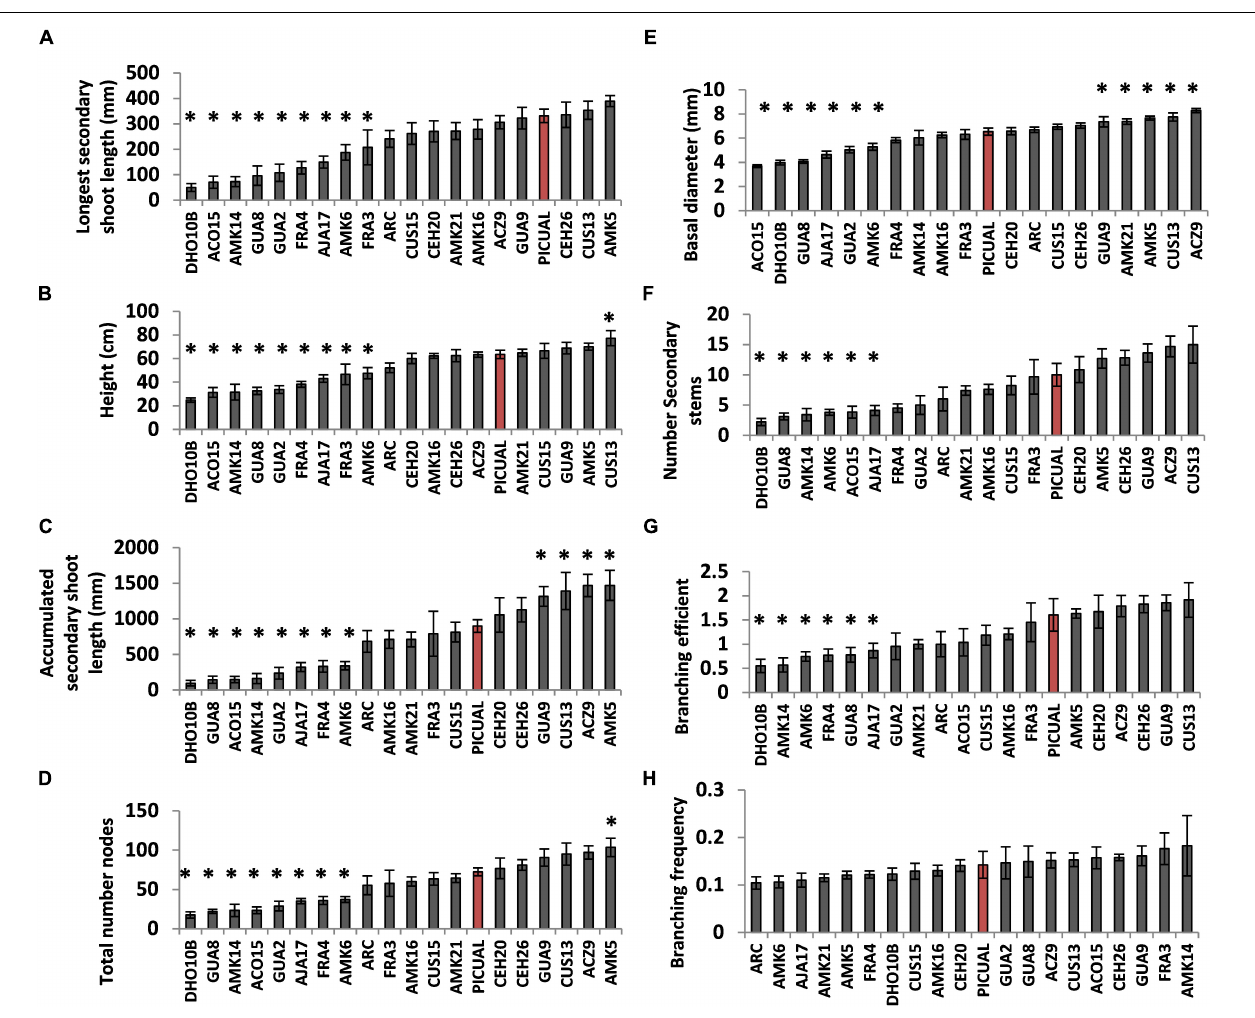
FIGURE 5 | Comparison of morphological parameters measured in the Picual scion grafted on different genotypes of the SILVOLIVE collection. Potted plants grown under greenhouse conditions were used 1 year after grafting. The parameters measured were: The longest secondary shoot length (A) ; the plant height (B) ; the accumulated secondary shoot length calculated as the sum of all secondary shoots length (C) ; the total number of nodes (D) ; the basal stem diameter at 5 cm from ground (E) ; the total number of secondary stems (F) ; the branching efficiency (G) ; and the branching frequency (H) . Bars are the average of 7–10 plants. Asterisks indicate significant differences with self-grafted Picual plants labeled as red bar. The data were subject to analysis of variance (ANOVA) and multiple comparisons of means were analyzed by Tukey’s HSD (honestly significant difference). Multiple range test was calculated using the Statistical Analysis System (STATGRAPHICS Centurion XVI software; http://www.statgraphics.com; StatPoint Technologies, Warrenton, VA, United